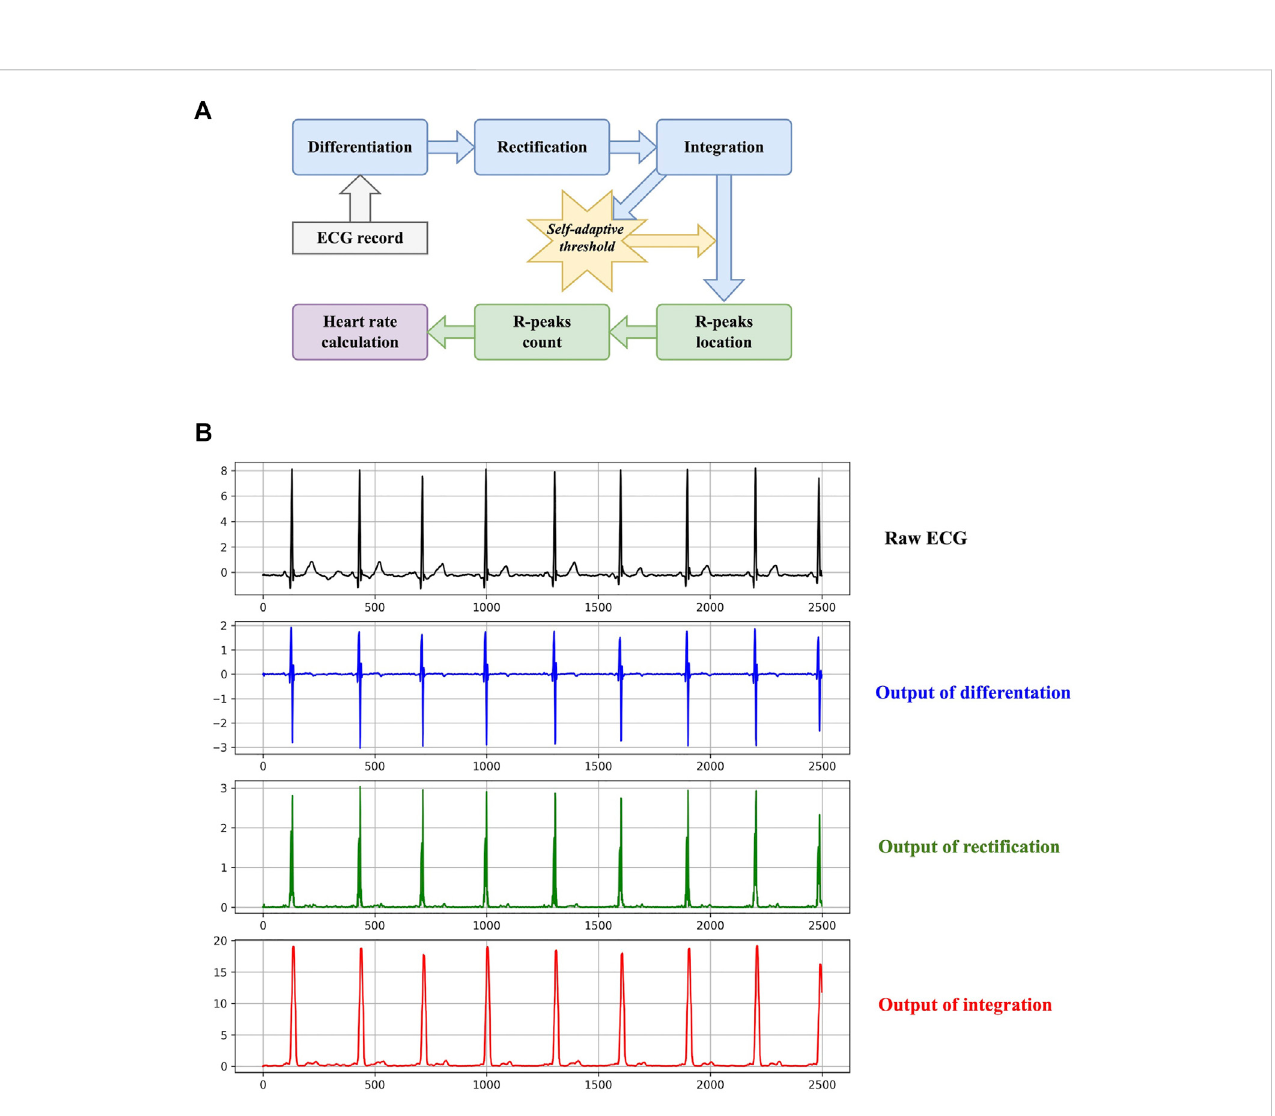
FIGURE 2 The method of the proposed heart rate estimator. (A) The diagram. (B) An example of the transformations presented in the diagram.